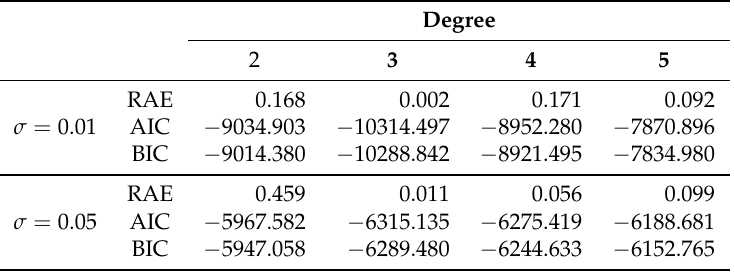
Table 2. Example 1. Measures for choosing the estimated model.